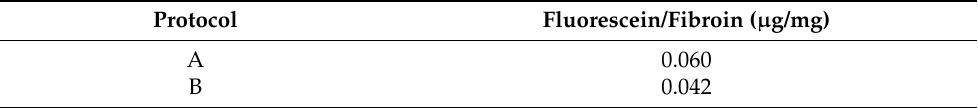
Table 1. Quantitative comparison of the fluorescein molecules covalently bound to fibroin using the functionalization protocols A (Functionalization of the protein in solution and subsequent spinning) or B (Immersion of the spun fibers in an FITC solution). Each value corresponds to the readout of the spectrophotometer obtained from a dissolution of 40 mg of a yarn of fibers functionalized with the corresponding procedure.